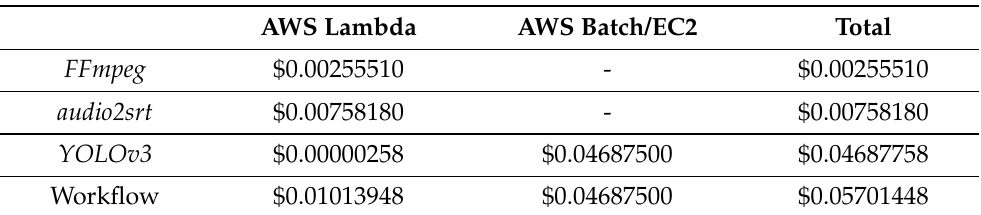
Table 1. Cost analysis of the first workflow execution distinguishing between the two AWS services used for the